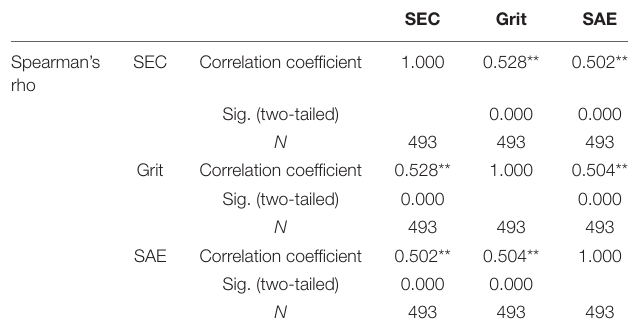
TABLE 3 | Test of normality for SEC, grit, and SAE.